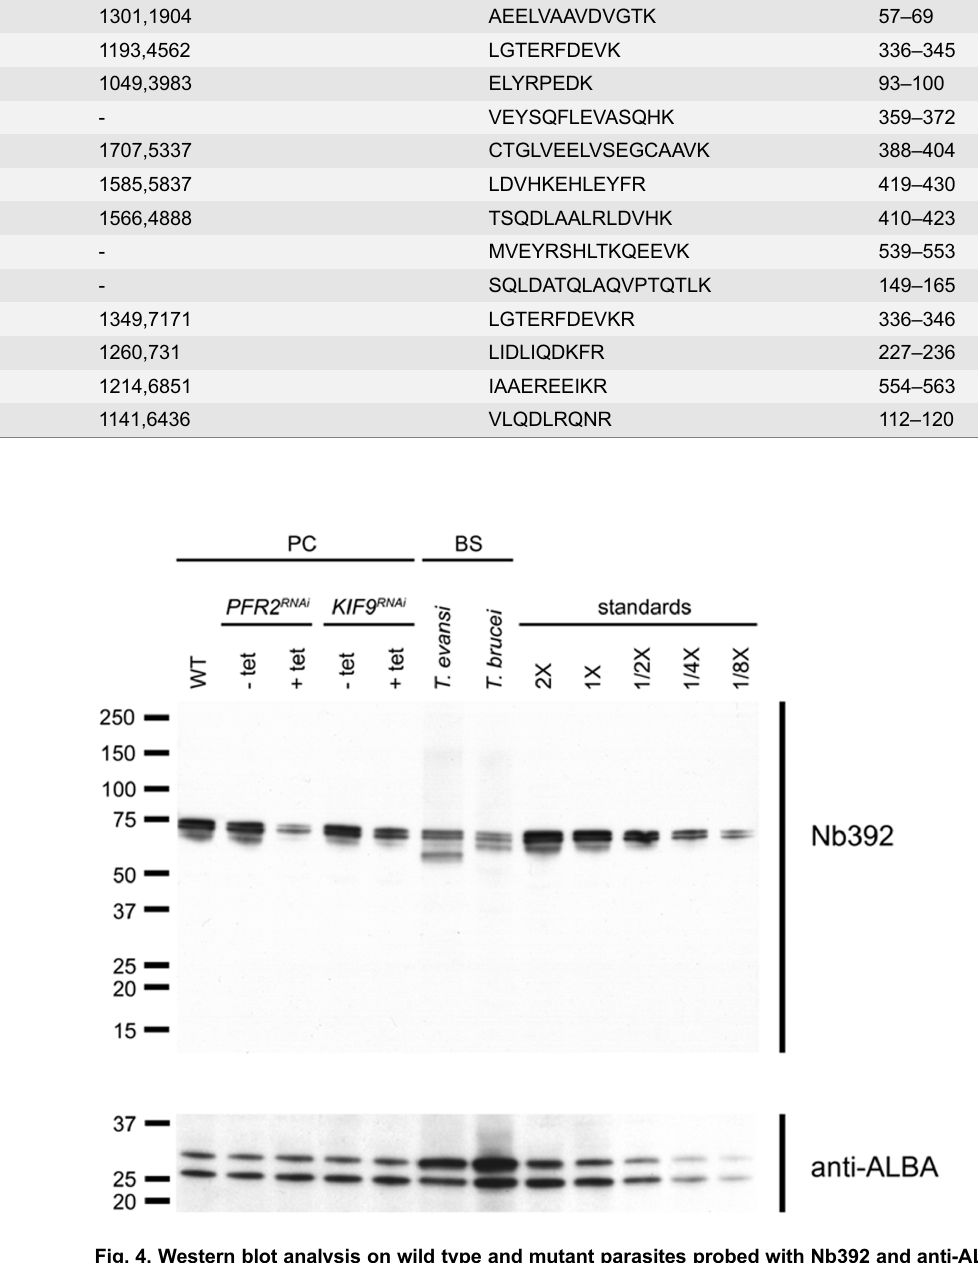
Fig. 4. Western blot analysis on wild type and mutant parasites probed with Nb392 and anti-ALBA as loading control. From left to right upper panel: WT T. brucei procyclics, PFR2 RNAi uninduced, PFR2 RNAi 2- day induction, KIF9B RNAi uninduced, KIF9B RNAi 4-day induction T. evansi blood form, T. brucei WT blood form, T. brucei procyclics WT calibration with 2 6 10 6 , 1 6 10 6 , 5 6 10 5 , 2.5 6 10 5 and 1.25 6 10 5 parasites. Lower panel: Anti-ALBA antibody used as loading control. Values on the left are given in kilodaltons.